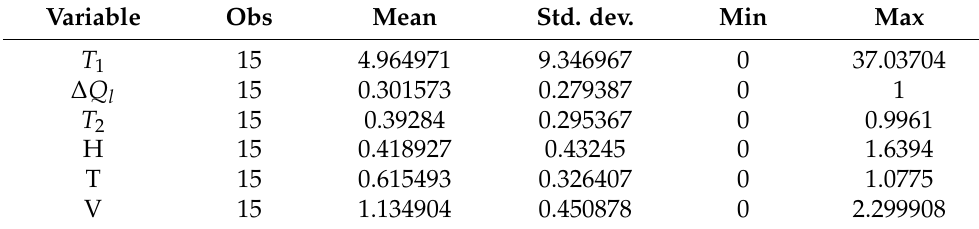
Table 2. Descriptive statistical analysis